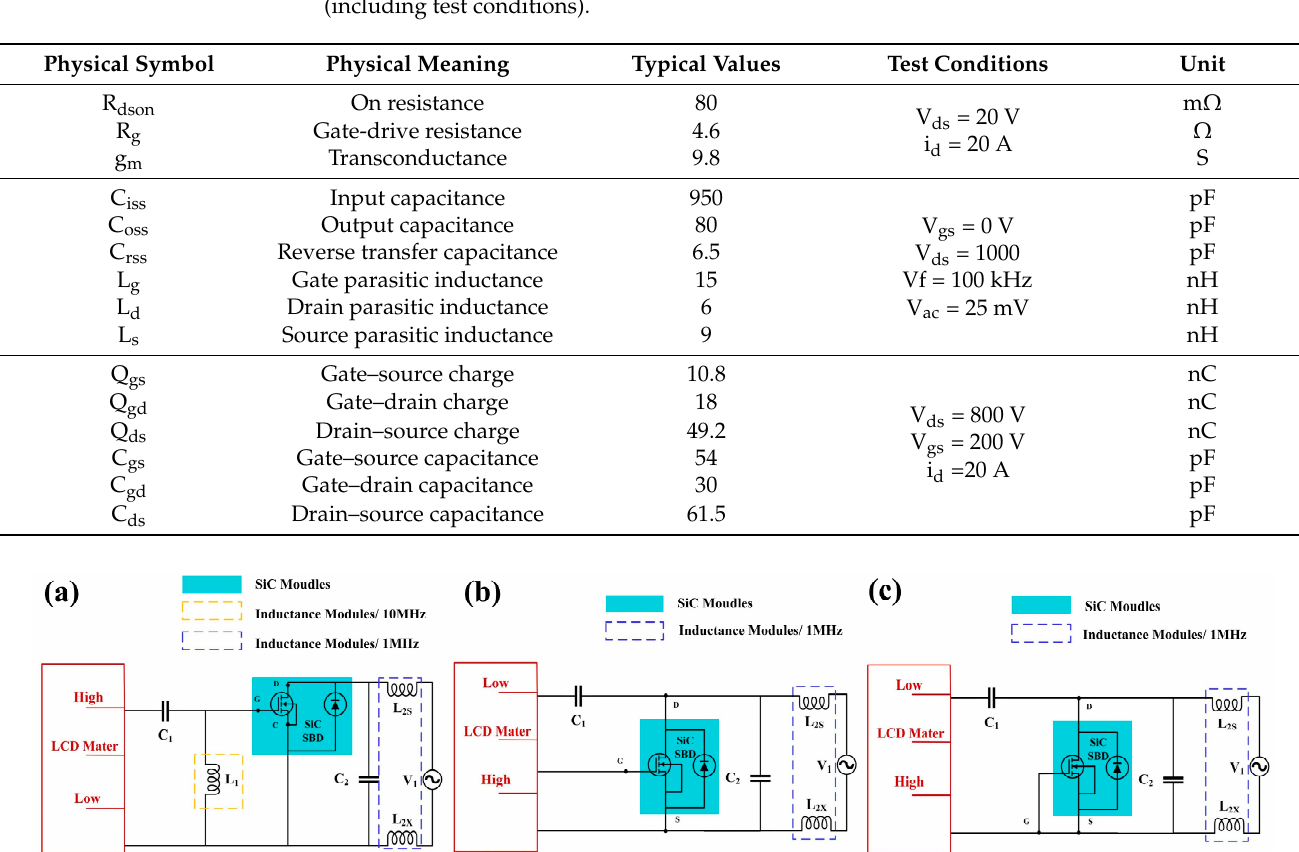
Figure 1. Single-loop test circuit of the high-frequency SiC module considering multiple parasitic parameters. Table 1. Multiple parasitic parameters on the single-loop test circuit of the high-frequency SiC module (including test conditions).